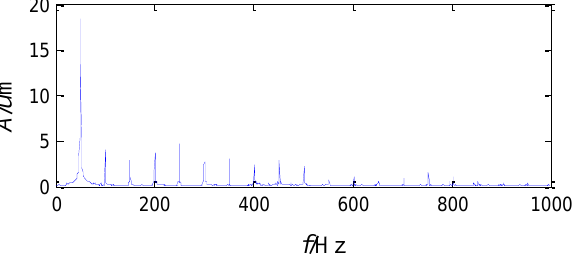
Figure 14. The FFT spectrum of the sensor-dependent vibration signal after